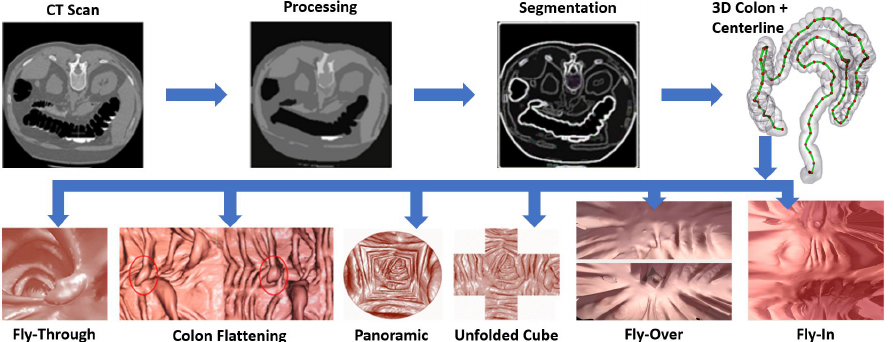
Figure 1. The CTC pipeline: First, DICOM images are cleaned, then colon regions are segmented. Secondly, the 3D colon is reconstructed from segmented regions, then centerline may be extracted. Finally, the internal surface of the colon can be visualized using different visualization